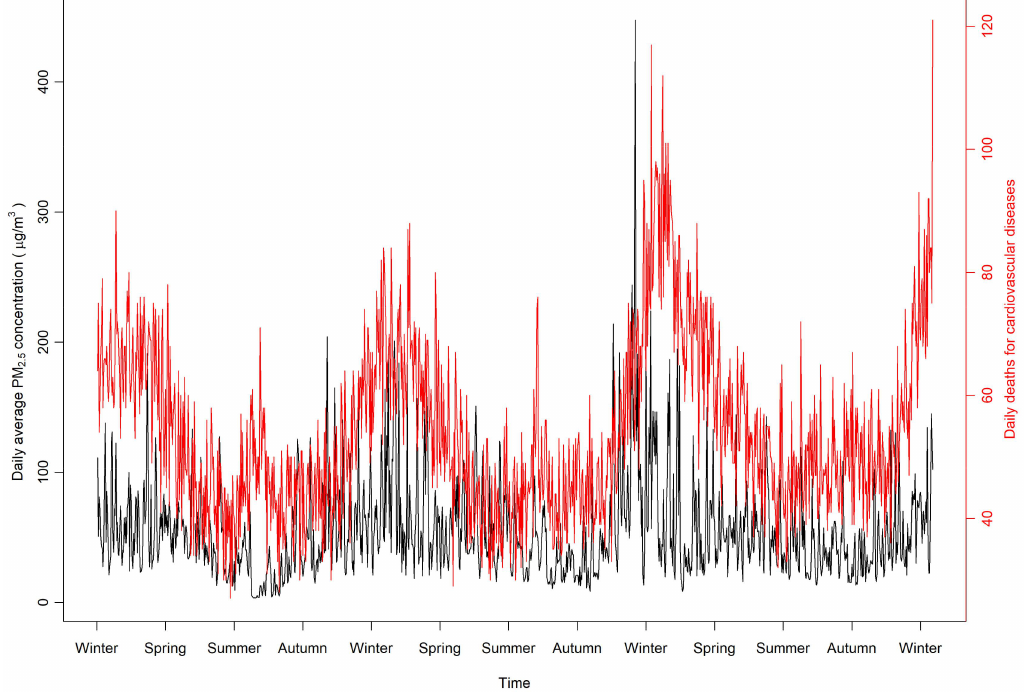
Figure 1. Time trends of daily ambient fine particulate matter (PM 2.5 ) concentrations and cardiovascular disease (CVD)